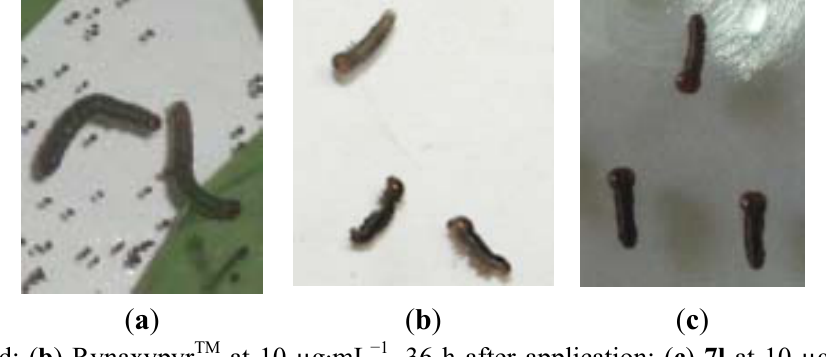
( a ) Untreated; ( b ) Rynaxypyr TM at 10 µg·mL − 1 , 36 h after application; ( c ) 7l at 10 µg·mL − 1 , 36 h after